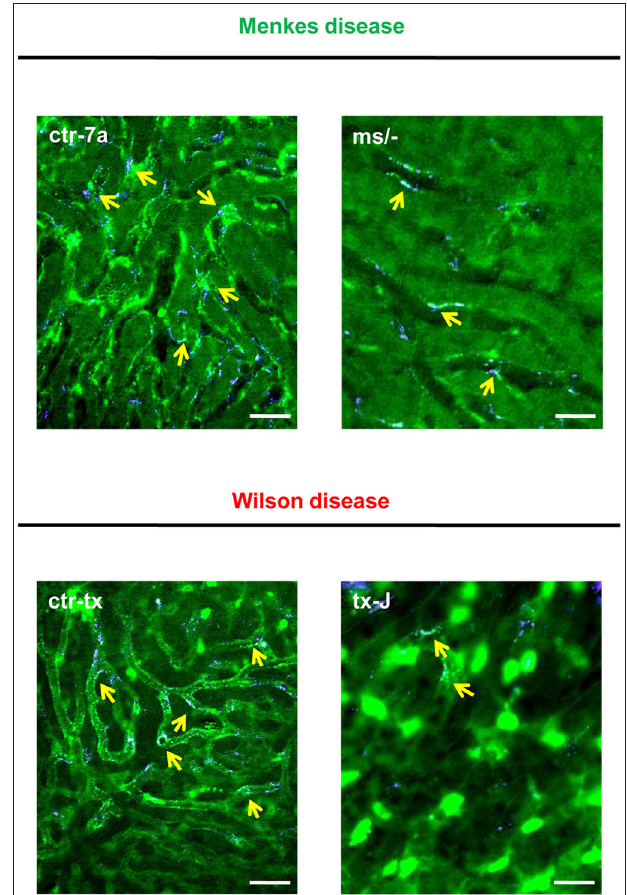
FIGURE 2 | Detection of NET components in the liver vasculature of endotoxemic Wilson (tx-J) and Menkes ( ms / − ) disease mice and their respective controls (ctr-tx and ctr-7a). On images, autofluorescent hepatocytes (dim green) as well as Sytox green + extracellular DNA (bright green) and NE signal (violet) are seen. Overlay of extDNA and NE is indicative of NETs (yellow arrows). The scale bar indicates 50 µ